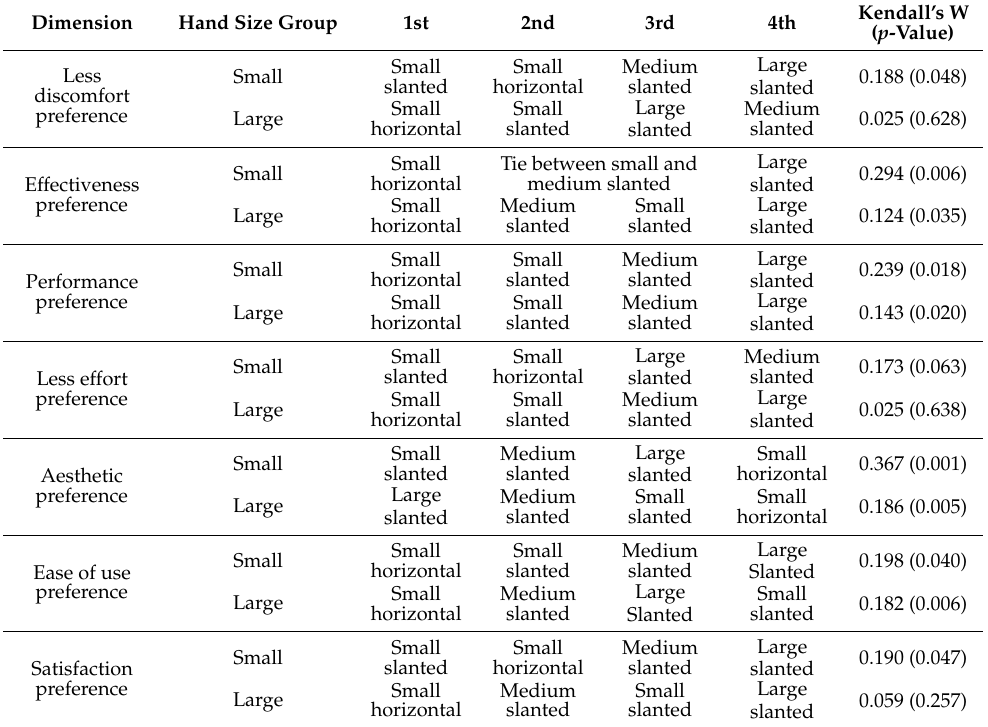
Table 4. Small ( n = 14) and Large ( n = 23) hand size groups (below and above the hand size parameter mean for the entire sample) and preference ranking among devices for various subjective